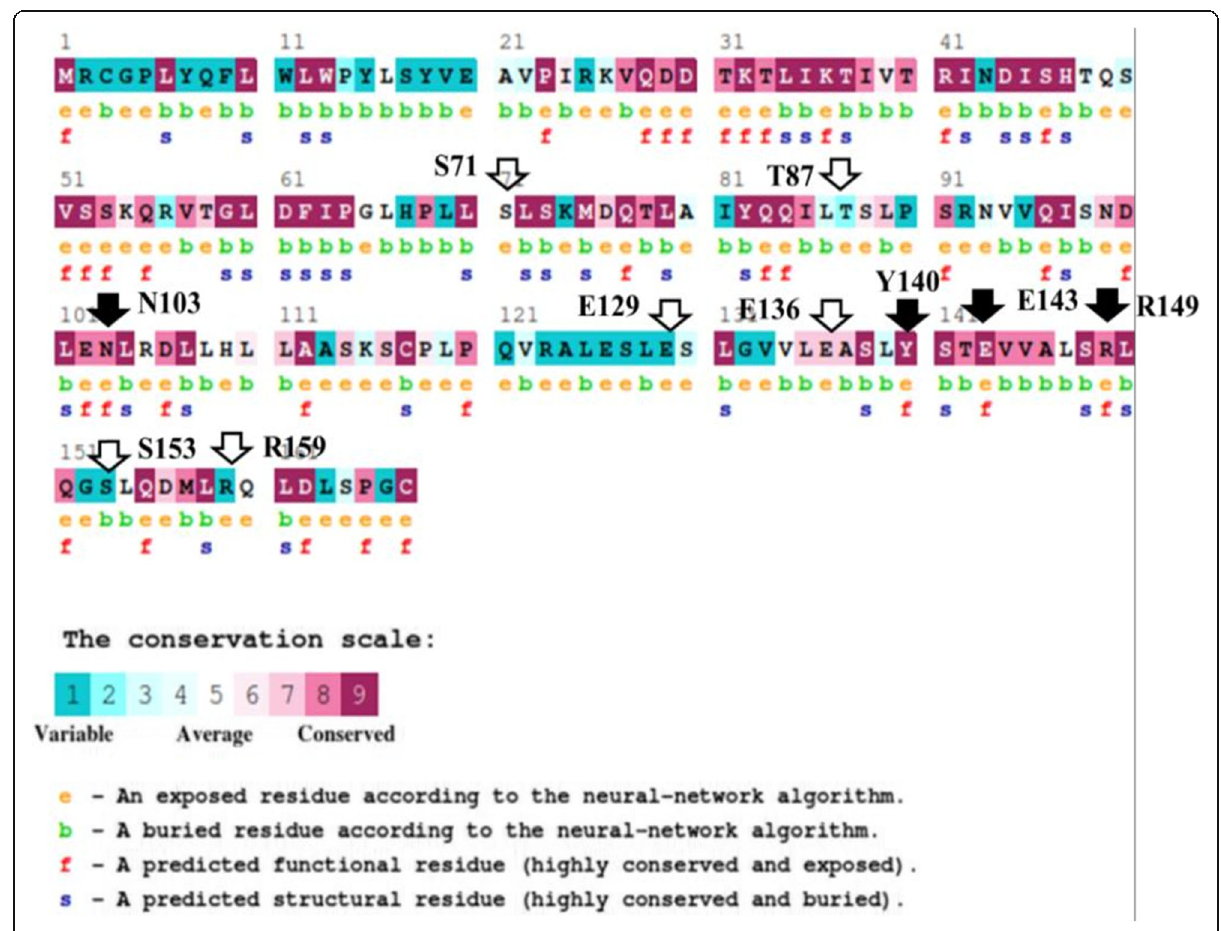
Fig. 5 The conservation degree of the leptin polypeptide amino acids. The mutated amino acids were marked by solid arrows (conserved sites) or empty arrows (non-conserved